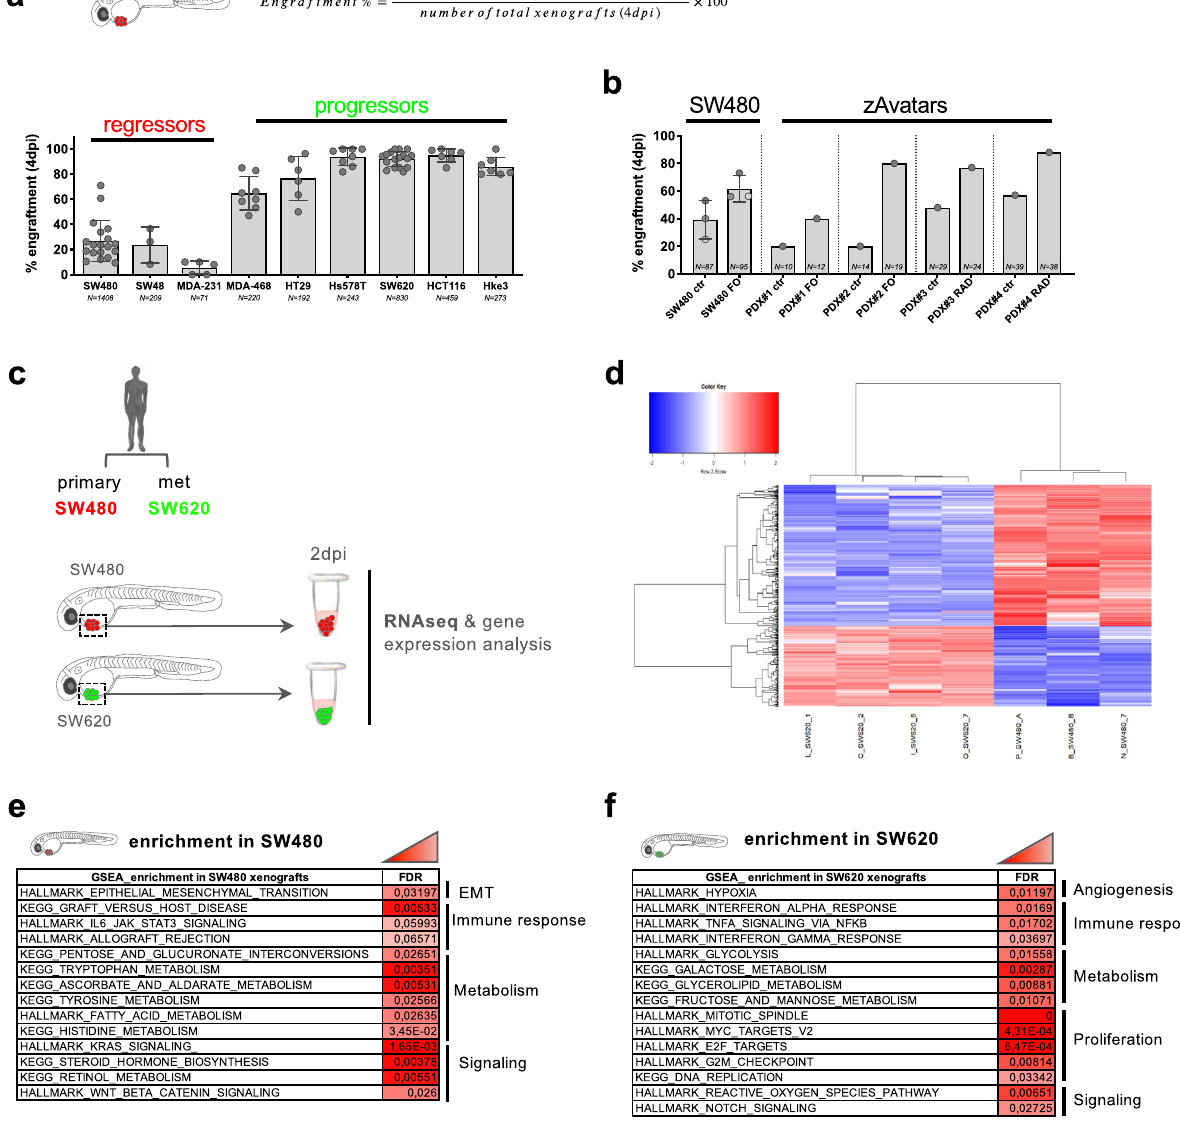
Fig. 1 Human cancer cells display differential engraftment pro fi les in zebra fi sh. a Engraftment is the ratio between the number of zebra fi sh xenografts that maintain a tumor at 4 days post injection (dpi) and the number of total xenografts that were originally successful injected and survived until day 4. MDA-MB-231 (MDA-231), MDA-MB-468 (MDA-468), and Hs578T are breast cancer cell lines. SW480, SW48, HT29, SW620, HCT116, and Hke3 are colorectal (CRC) cancer cell lines. Tumor cells were labeled and injected into the perivitelline space (PVS) of 2 days post-fertilization (dpf) zebra fi sh embryos. Each dot represents one independent experiment, number of independent experiments: 19 SW480, 3 SW48, 5 MDA-231 12 MDA-468, 5 HT29, 7 Hs578T, 22 SW620, 6 HCT116, 7 Hke3. Total number of xenografts analyzed ( N ) is depicted in the charts. Error bars indicate mean ± S.D. b Engraftment of SW480 and zebra fi sh patient-derived xenografts (zPDX-zAvatars) at 4 dpi, treated with FOLFOX (FO) and radiotherapy (RAD) and their respective controls. Each dot represents one independent experiment (3 SW480, 1 zPDX). Total number of xenografts analyzed ( N ) is depicted in the charts. Error bars indicate mean ± S.D. See also Supplementary Fig. 1. c – f Comparative transcriptomic analysis between SW480 and SW620 xenografts. c Schematic representation of the experiment where SW480 (in red) and SW620 (in green) tumors were dissected at 2 dpi for RNA extraction (~30 tumors of each condition). d Heatmap presents a two-dimensional dendogram (based on Pearson ’ s correlation coef fi cient distance) of log2 counts-per-million (logCPM), normalized expression values of differentially expressed genes ( N = 459, cut-off of FDR < 0.05 and absolute log2FC > 1) in SW480 (low engraftment) versus SW620 (high engraftment) comparison, where colors represent expression values scaled by row (Z-scores). e , f GSEA of SW480 and SW620 xenografts. Source data are provided as a Source data fi